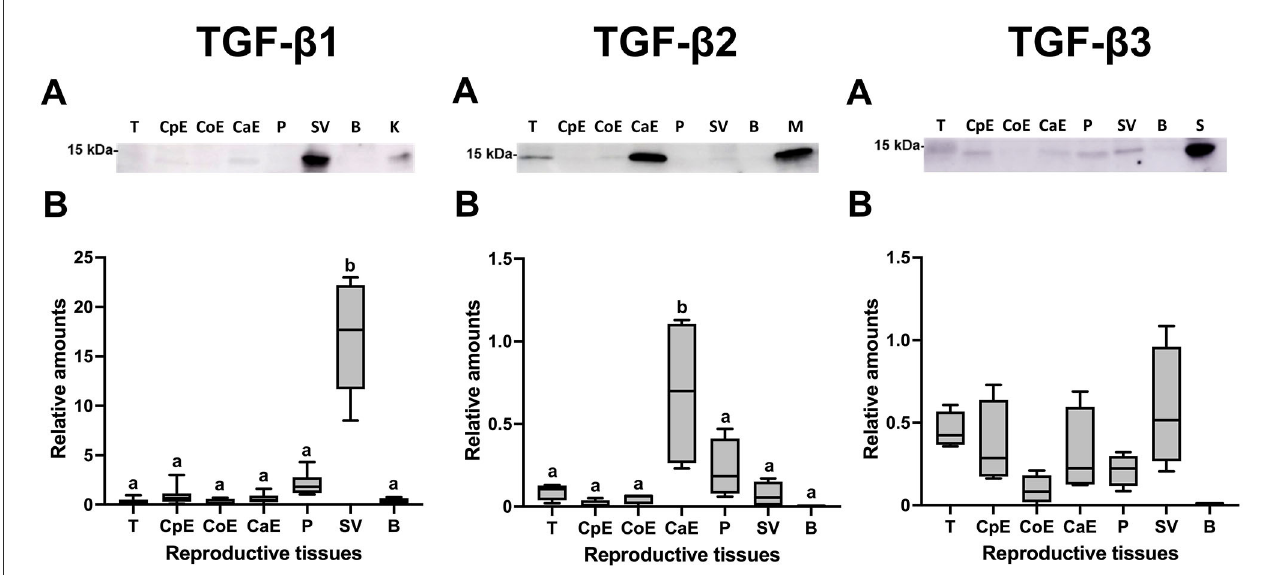
FIGURE5 Western blot analysis and relative amount of Transforming Growth Factor (TGF)- β 1, - β 2 and - β 3 in pig male reproductive tissues. (A) TGF- β 1, - β 2, and - β 3 expression of mature band ( ∼ 15 kDa) in internal reproductive tissues: testes (T), caput epididymis (CpE), corpus epididymis (CoE), cauda epididymis (CaE), prostate (P), seminal vesicle (SV) and bulbourethral gland (B). (B) Relative amount of mature TGF- β 1, - β 2, and - β 3 band ( ∼ 15 kDa) in internal reproductive tissues. The plots show data from at least four biological replicates. Boxes enclose the 25th and 75th percentiles, whiskers extend to the 5th and 95th percentiles and the line indicates the median. Different letters above bars indicate significantly different values ( p < 0.05).